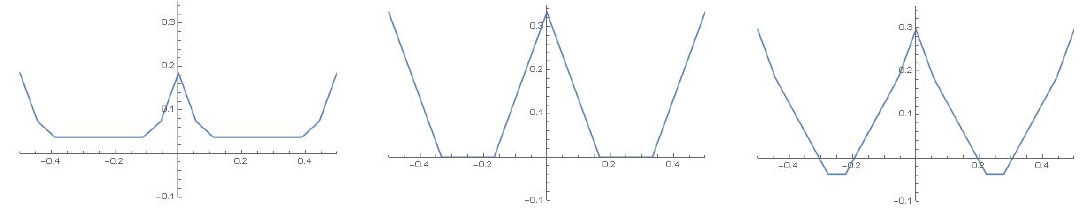
Figure 3 . The L h function (3.4) in the N = 2 case, as a function of x 1 , for T 1 ; 2 = (cid:0) 1 = 9 (left), T 1 ; 2 = (cid:0) 1 = 3 (middle), and T 1 ; 2 = (cid:0) 4 = 9